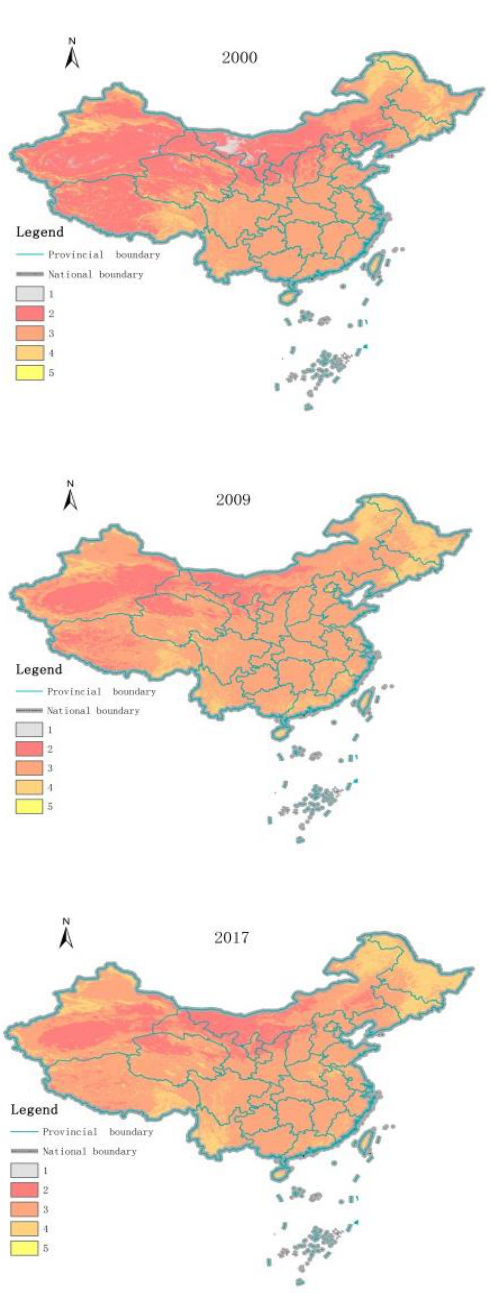
Figure 3. Regional spatial distributions of the RSEI in China in 2000 – 2017. Table 3. Percentage of areas of the types of ecological regions according to the RSEI of China from 2000 – 2017.